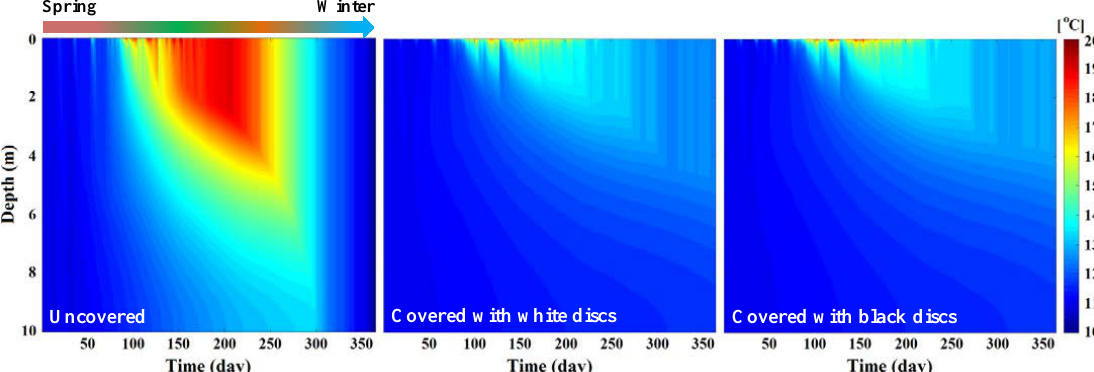
Figure 8. Modeling the effect of surface coverage on mean daily temperature in a hypothetical reservoir with 10m depth using meteorological data (European Fluxes Database) in Majadas, Spain (March 2004 to March 2005); the reservoir was covered using white and black Styrofoam discs (diameter: 0.2m and height: 0.02m) that provide 0.91 coverage of the reservoir surface. A uniform vertical temperature at 11 ◦ C was assumed as the initial condition, and the bottom boundary condition was set to zero heat